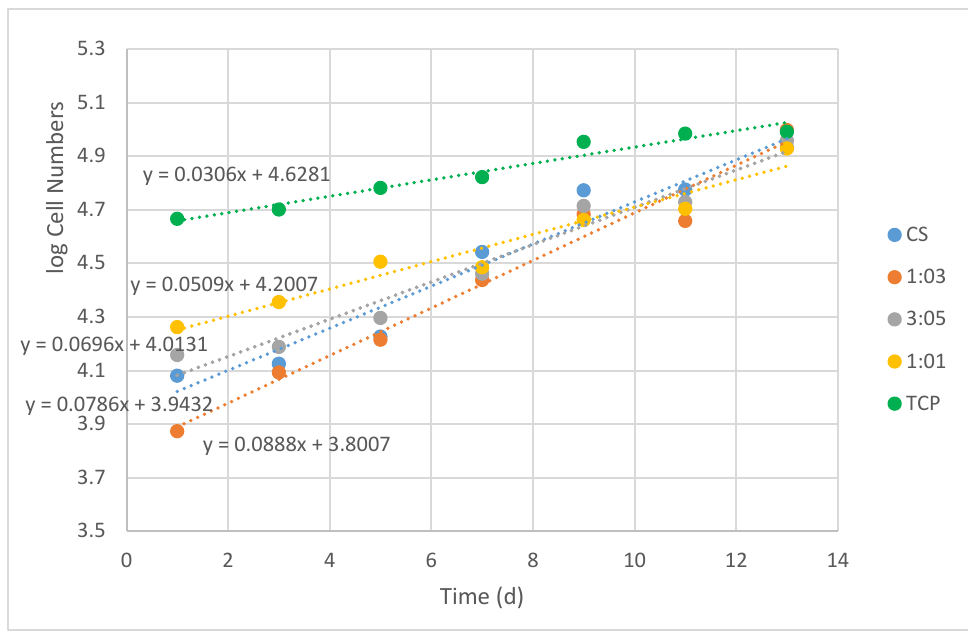
Figure A3. Indicative proliferation rates for human fibroblasts.